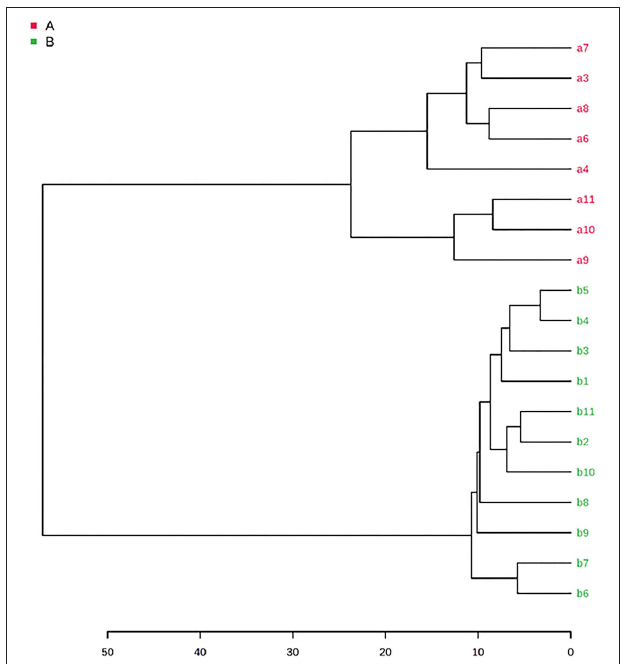
FIGURE 4 | HCA dendrogram of Tuber Aestivum and Tuber Borchii (Samples belonging to the Tuber Aestivum species are shown in red color, and the samples belonging to Tuber Borchii species are shown in green color).